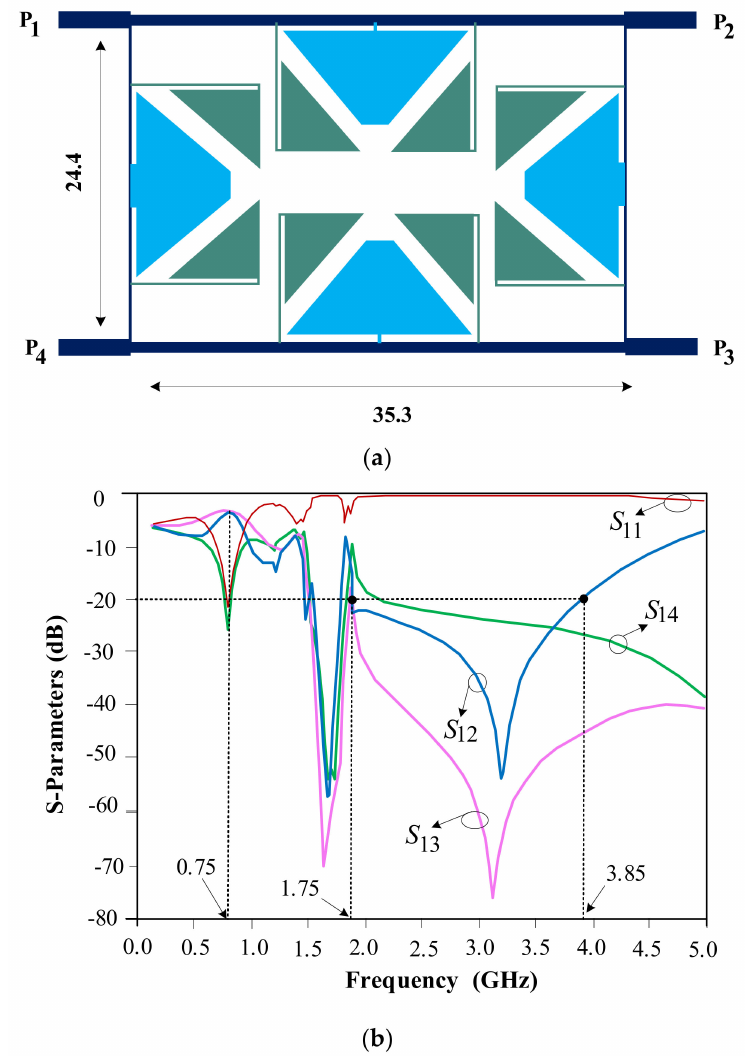
Figure 13. The preliminary prototype of the designed coupler; ( a ) layout with dimensions in millime- ters, and ( b ) EM simulation